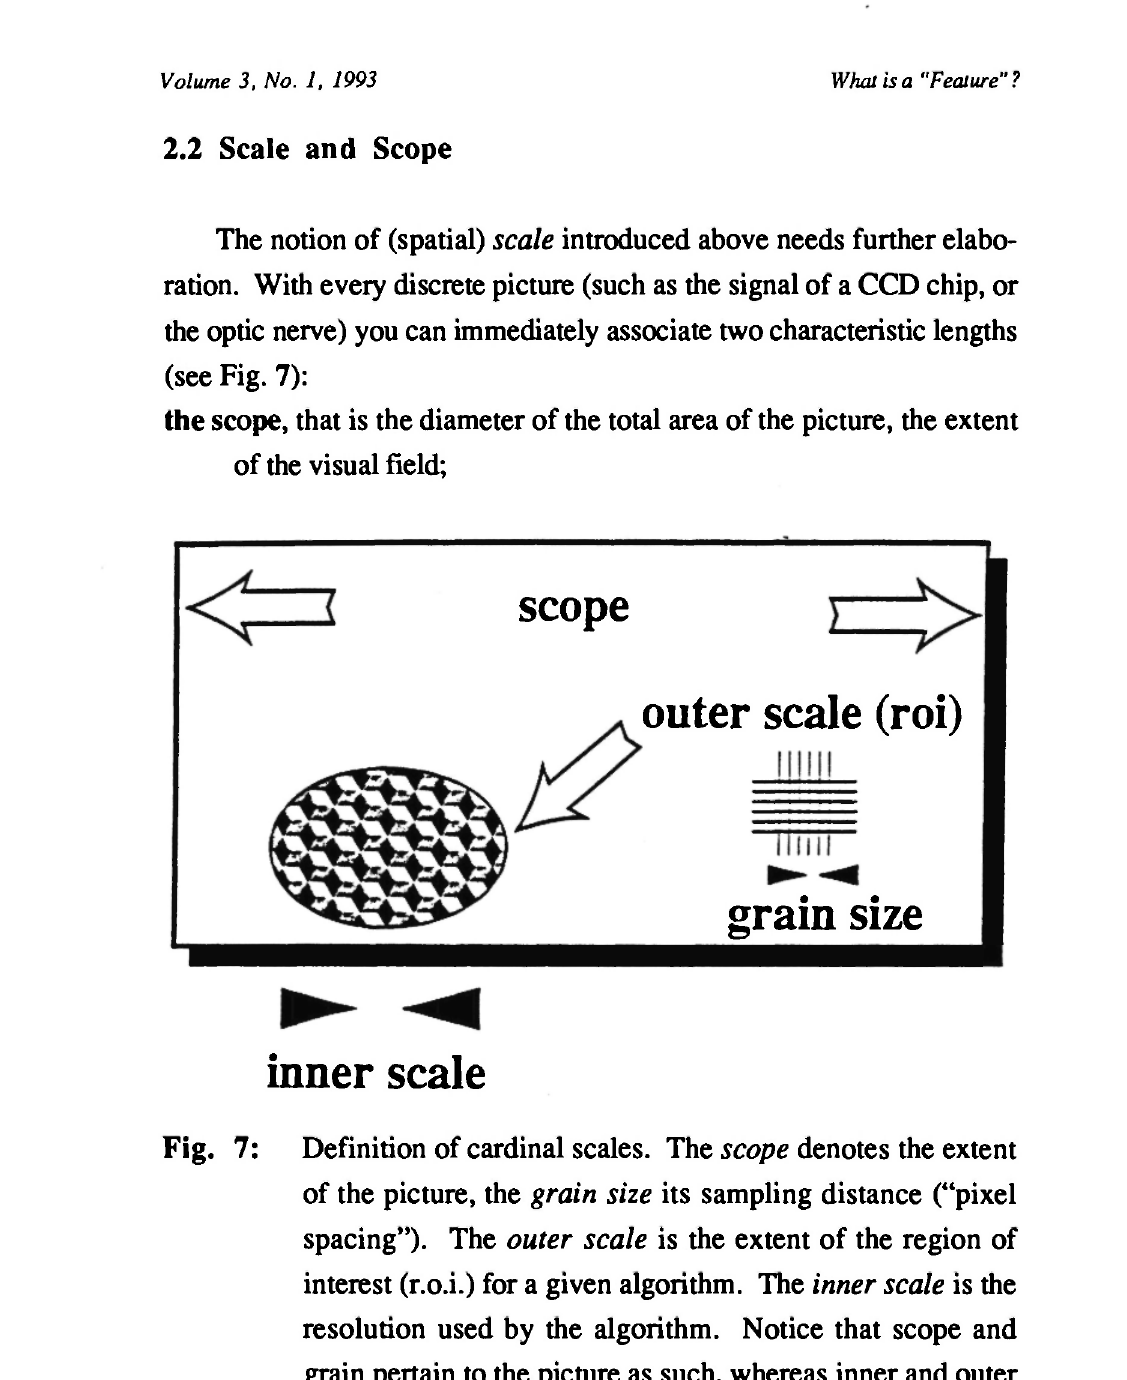
Fig. 7: Definition of cardinal scales. The scope denotes the extent of the picture, the grain size its sampling distance ("pixel spacing"). The outer scale is the extent of the region of interest (r.o.i.) for a given algorithm. The inner scale is the resolution used by the algorithm. Notice that scope and grain pertain to the picture as such, whereas inner and outer scale pertain to algorithms applied to the picture. It is gene- rally desirable that the outer scale be much smaller than the scope, the inner scale much larger than the grain